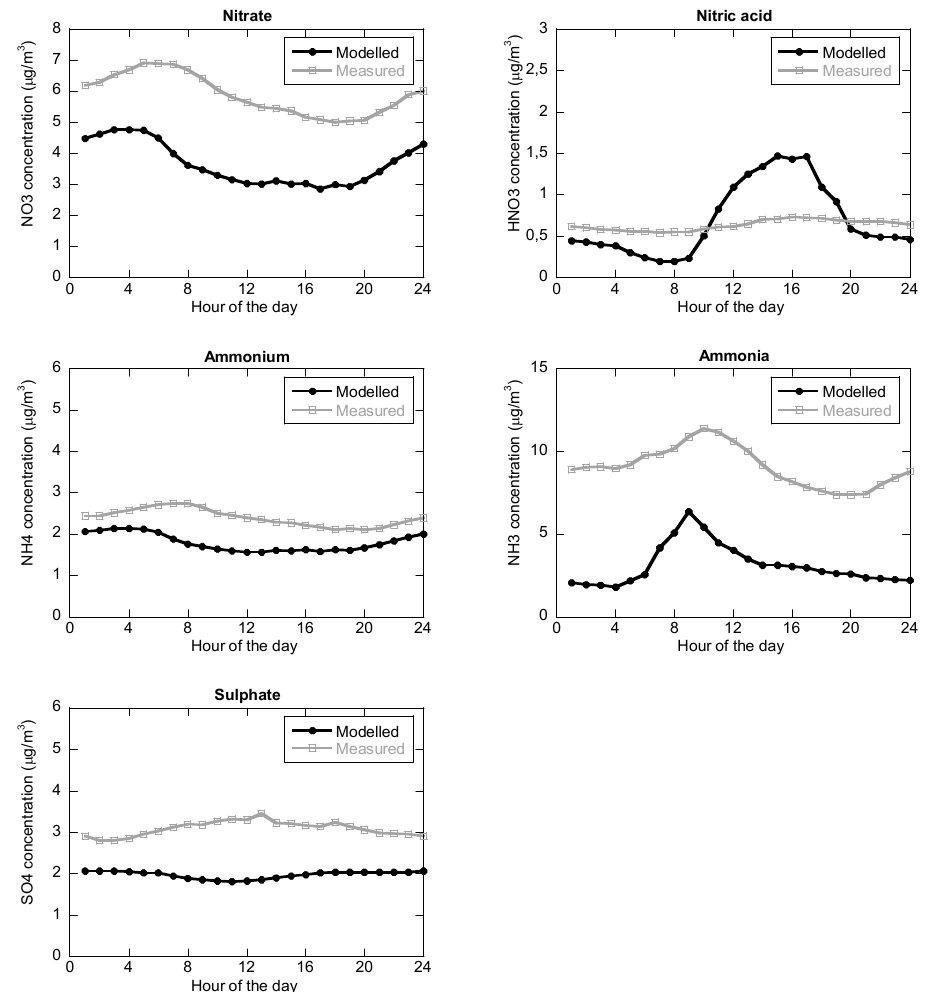
Fig. 6. Comparison of the measured (grey) diurnal cycle for nitrate, sulphate, ammonium, nitric acid and ammonia at Cabauw with 7km grid resolution estimates (black) of the LOTOS-EUROS model for this